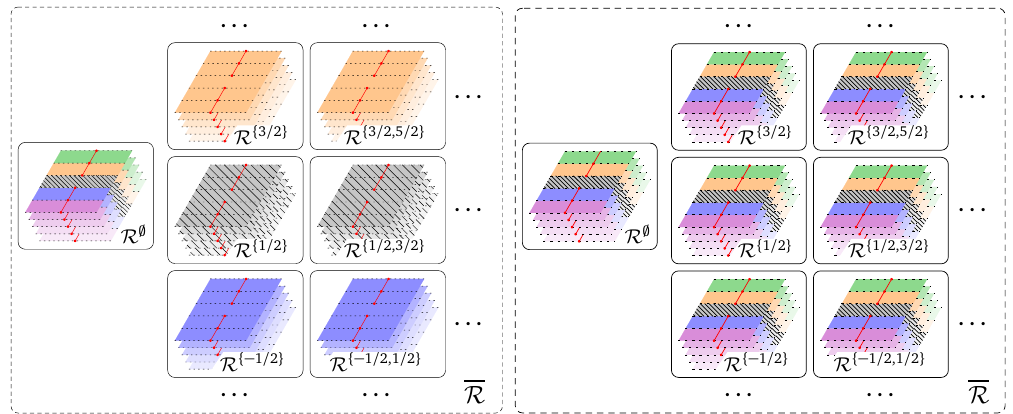
Figure 17: Two choices for the fundamental domain of the collection of Riemann sur- faces R under the action of g . The fundamental domain is the hatched portion. How sheets are glued together is not represented for clarity. For the connected component R (cid:59) = R of R , the fundamental domain ˇ R is chosen as in figure 13